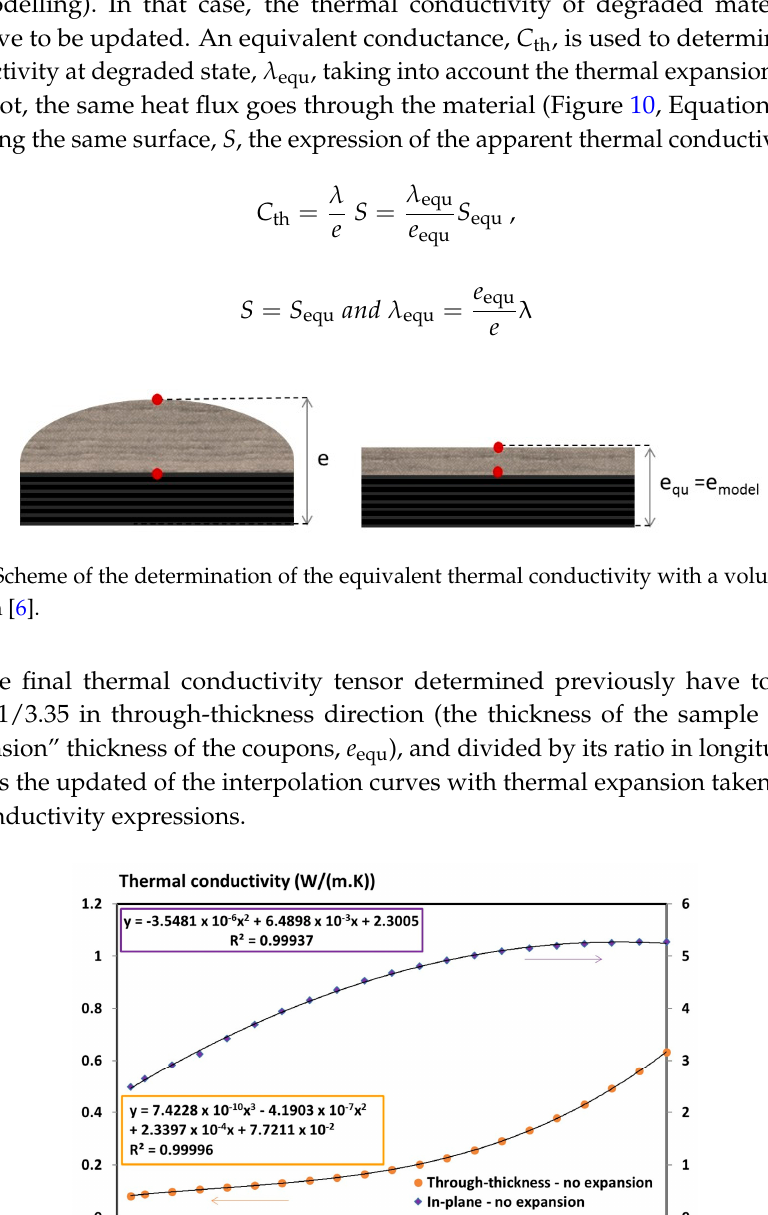
Figure 11. Through-thickness and in-plane thermal conductivity of the degraded T700/M21 composite as a function of the temperature [6].